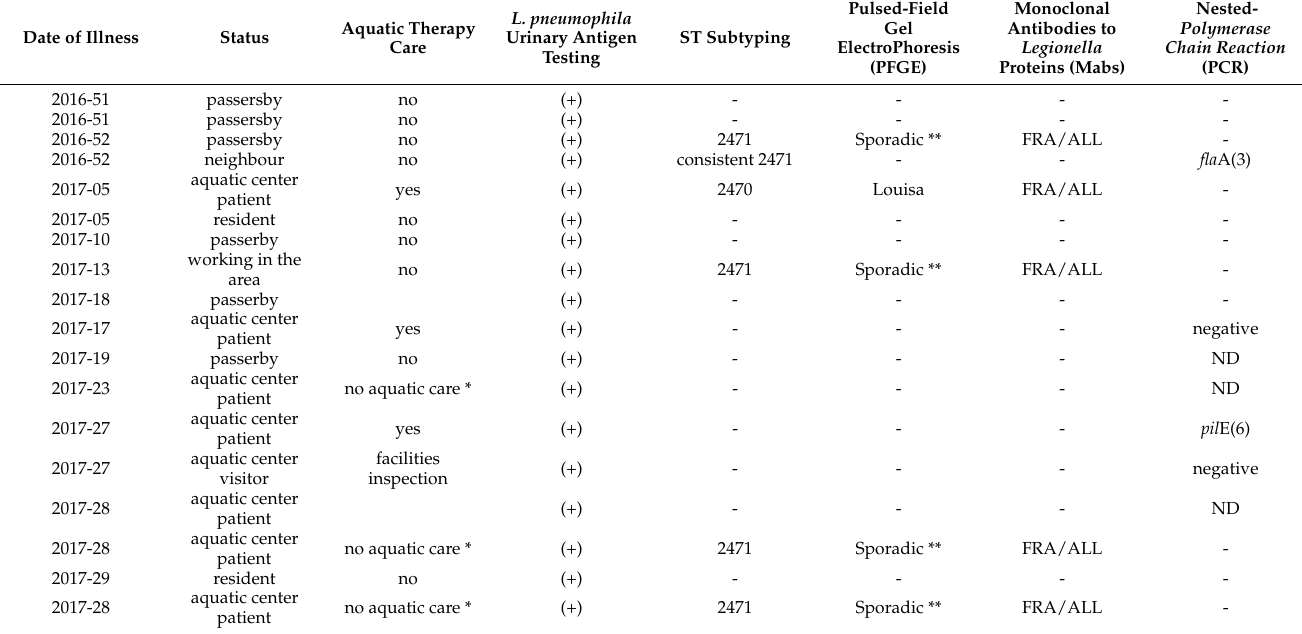
Table 1. Epidemiological and microbiological characteristics of patients with outbreak-related L.